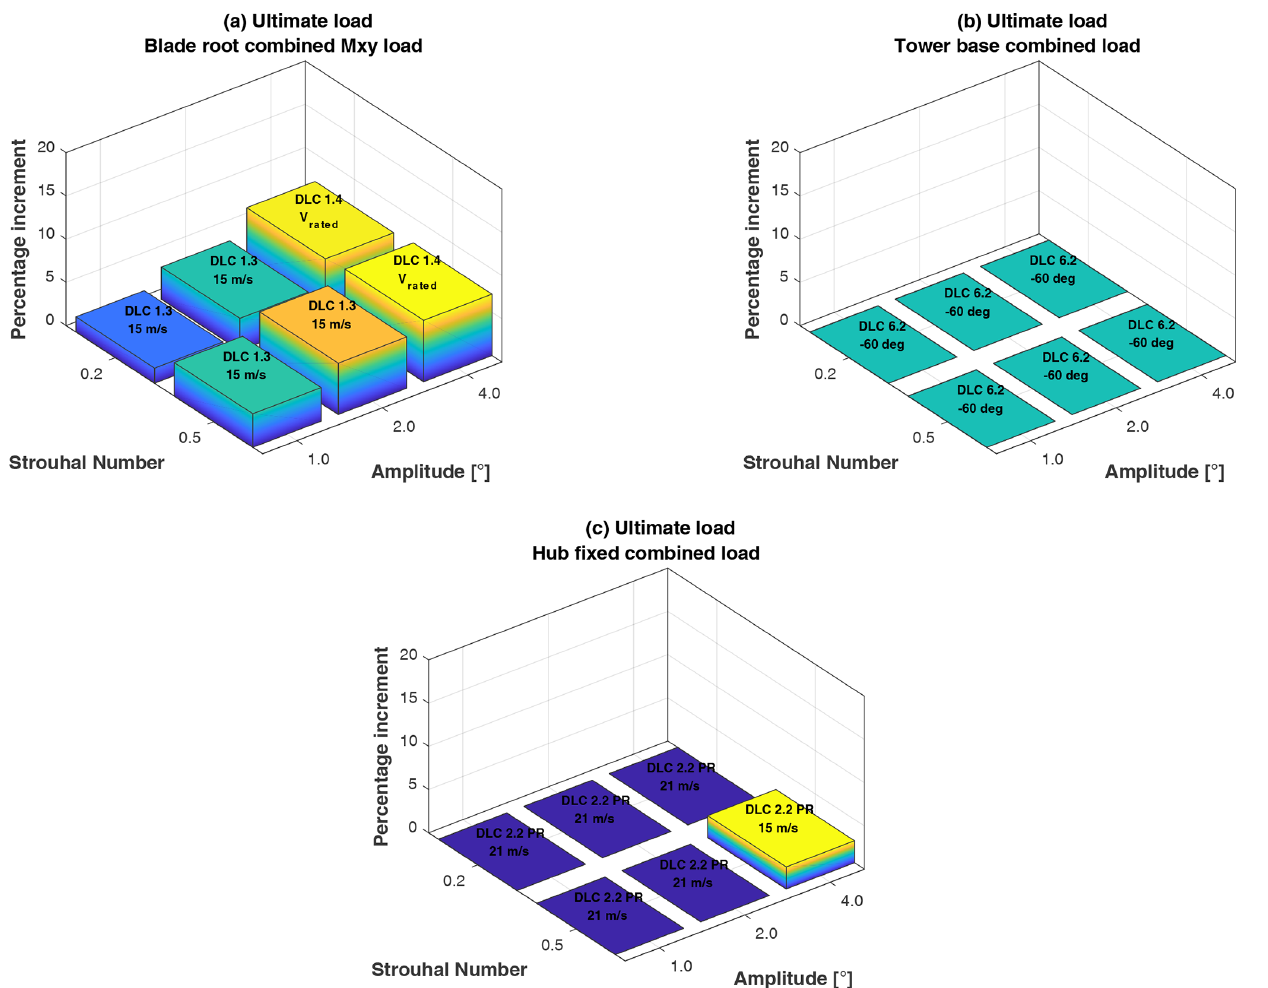
Figure 6. Maximum load increases as function of amplitude and Strouhal number. (a) Blade root combined moment. (b) Tower base combined moment. (c) Hub combined moment. Table 2. Comparison of worst cases (PCM vs